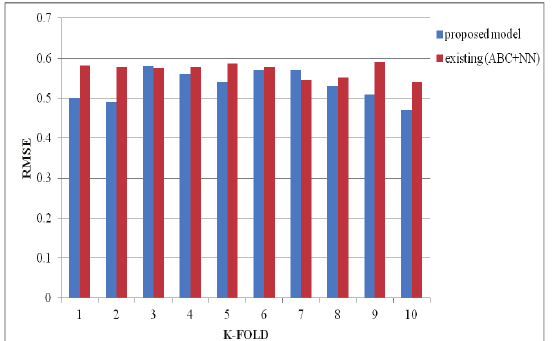
Fig.9. MAPE based Comparison graph of proposed against existing using k-fold cross validation method